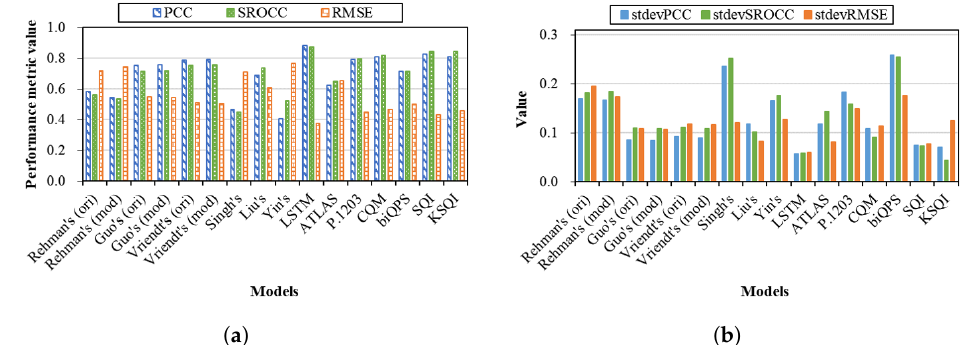
Figure 5. Average and standard deviation performance of the models over all the databases. ( a ) aver- age performance; ( b ) standard deviation